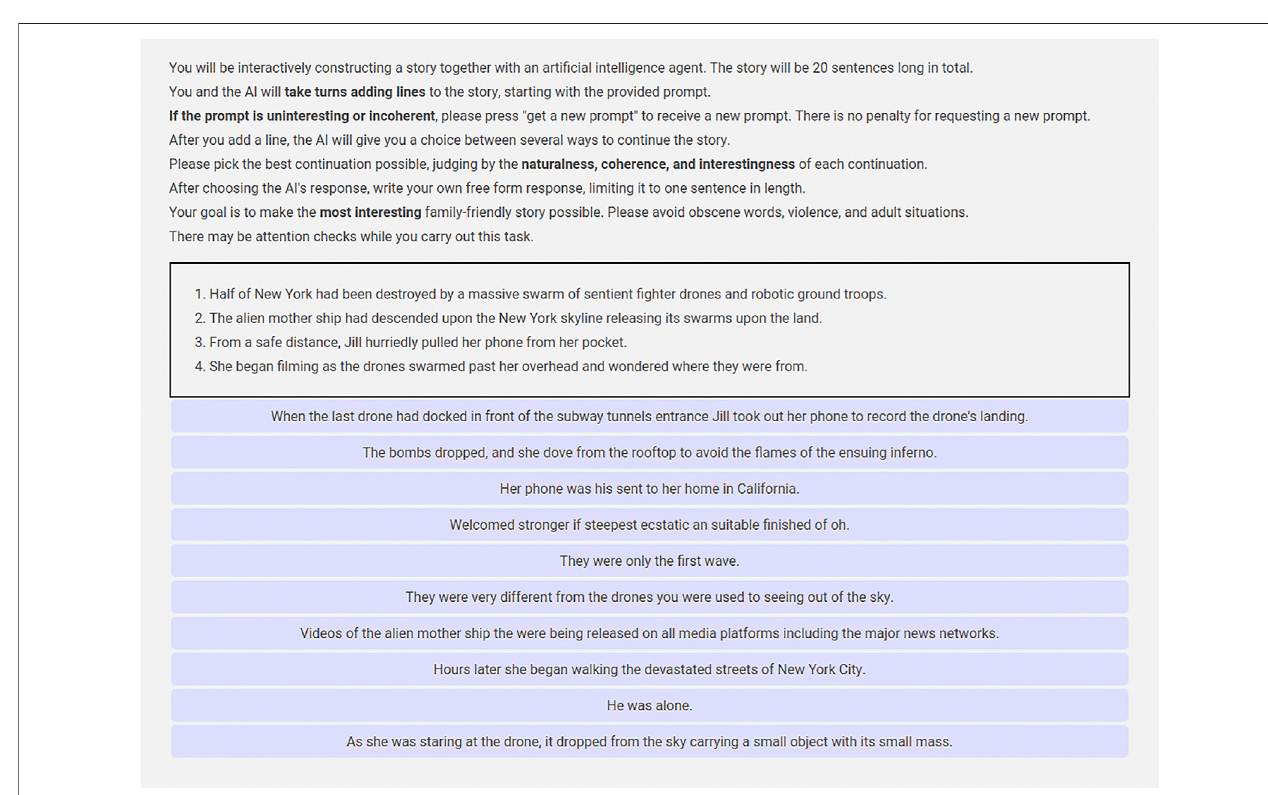
FIGURE3| Webinterfaceforcollaborative storytellingannotationtask.Participantsselectfromamongsttenpossiblestorycontinuationsgeneratedbythe system before adding their own line to the story. Reproduced with permission from (Nichols et al., 2020).